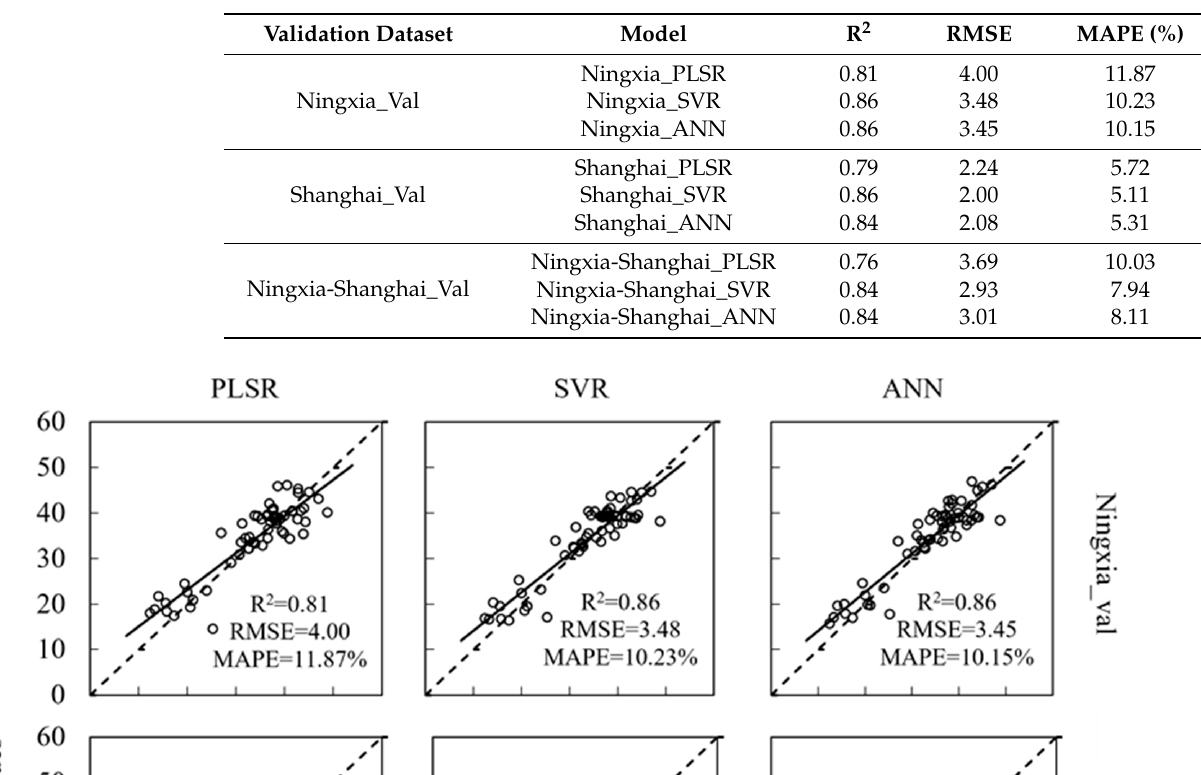
Table 6. Validation of rice leaf LCC estimation models for the same group.